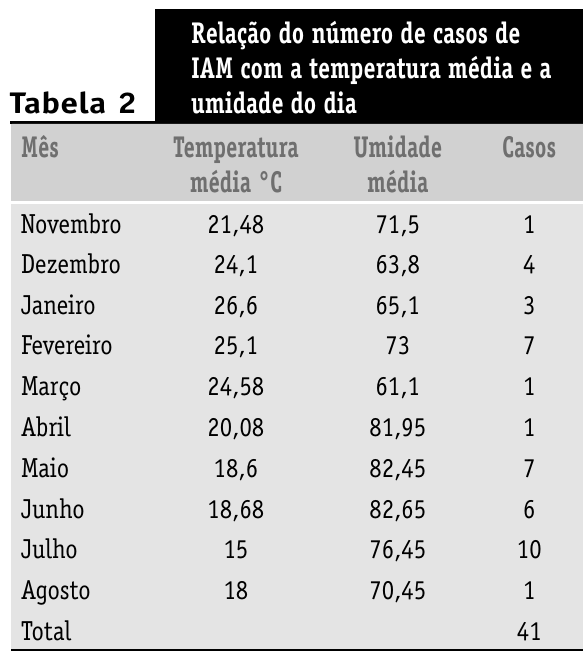
Para Ht e plaquetas, a média dos resultados obtidos não apresentou diferença significativa entre os grupos (Tabela